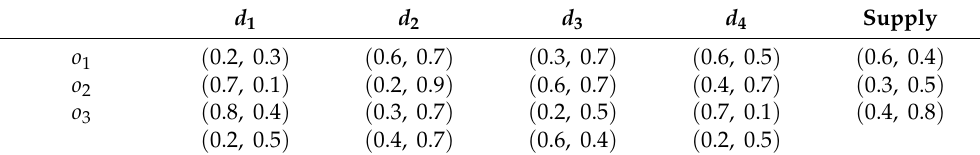
Table 3. Third Objective